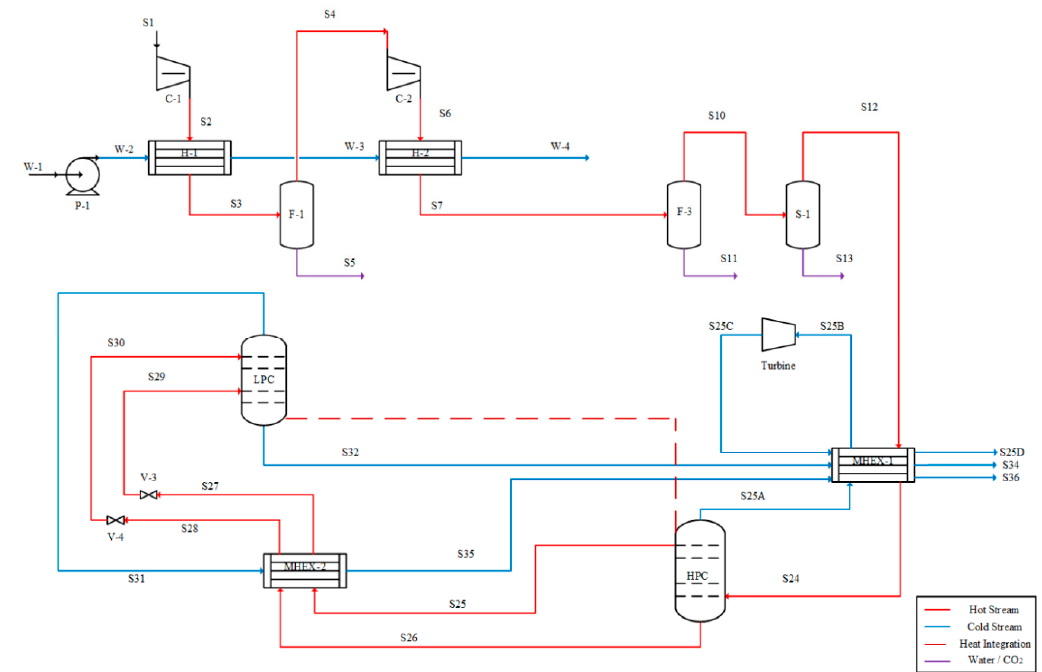
Figure 5. Process flow diagram of the ASU configuration C5. Table 5. Steady-state simulation results for the ASU configuration C5.